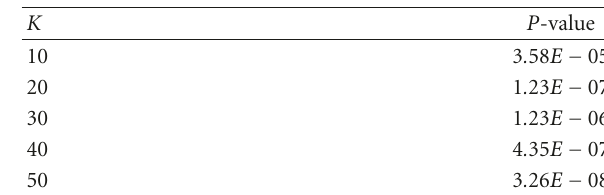
Table 1: The P -values obtained from the paired t -test on perplexity results of Nie et al.’s and proposed method for di ff erent numbers of latent topics ( K